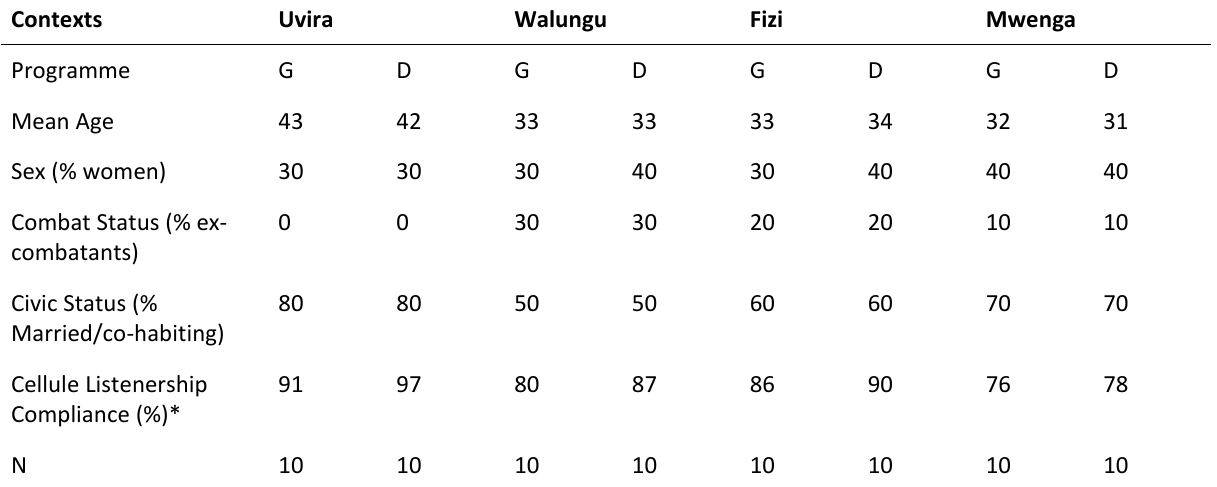
Table 2. Demography of autochthon network Focus Group